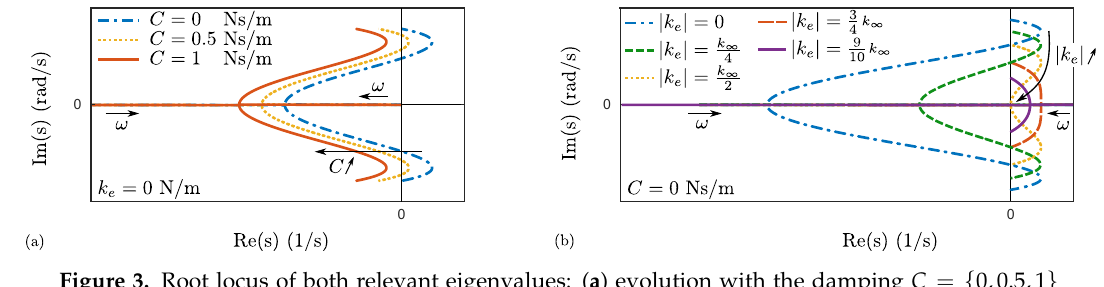
} k ∞ N/m for , 1 , 3 , 9 2 4 4 10